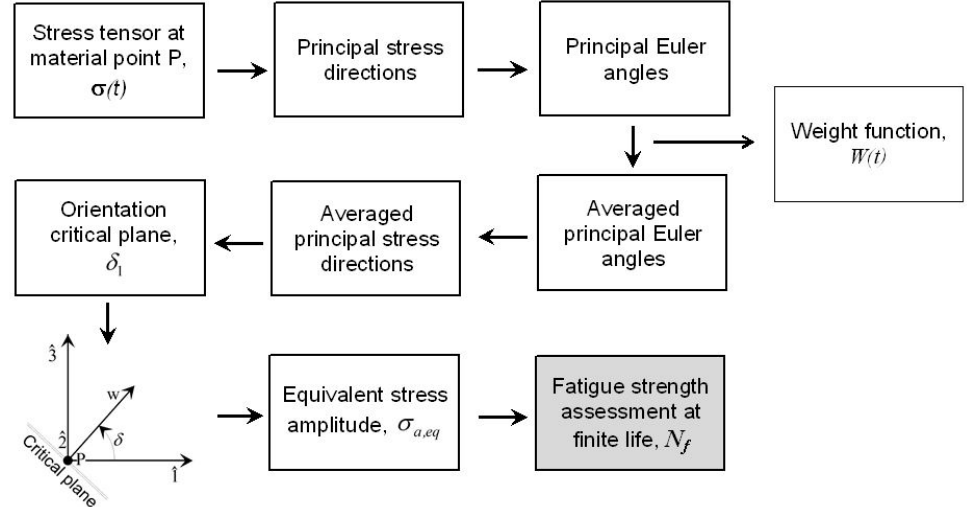
Figure 1: Graphical representation of the modified C-S